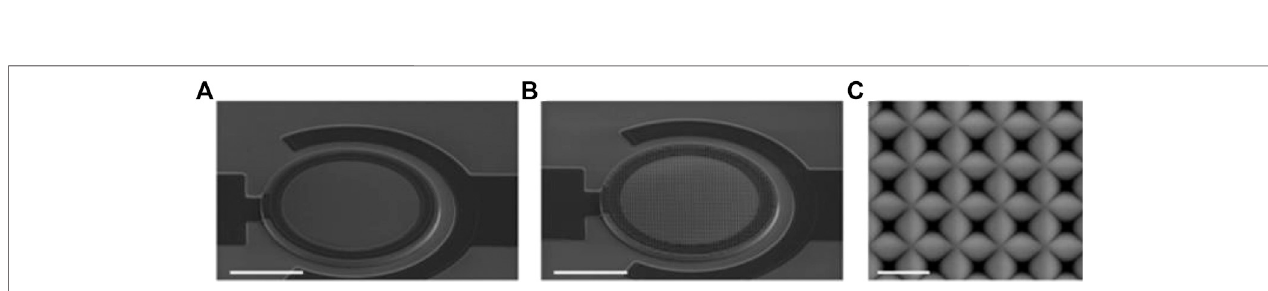
FIGURE 3 | Structure of control SPAD (A) and light-trapping SPADs (B) , both with 50 μ m diameter. Scale bar in both 20 μ m. (C) SEM image (top-down view) of inverse pyramid nano-structure on light-trapping SPAD. Scale bar, 1 μ m. Source : Reproduced from Ref. 13.